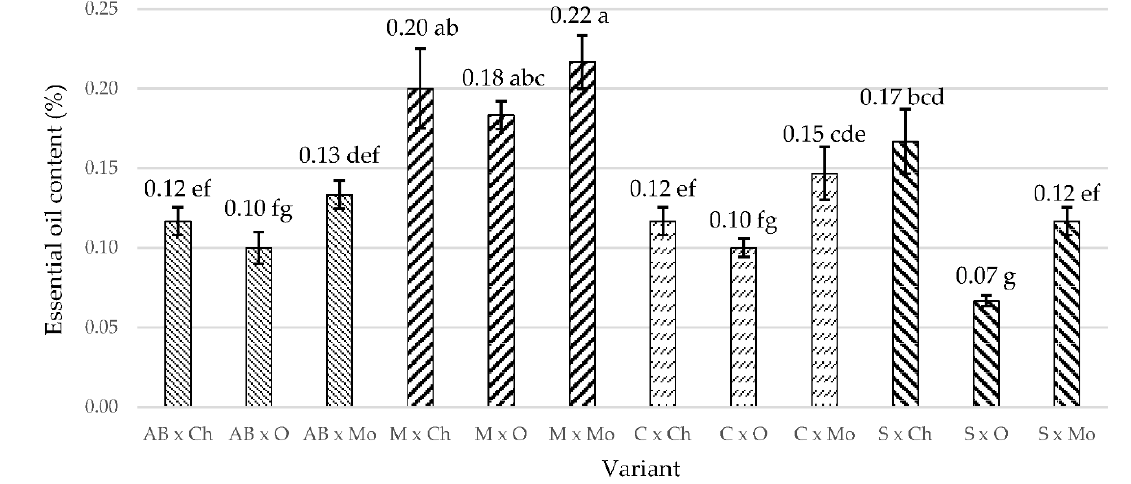
Figure 1. Interaction effects of cultivar and fertilization on essential oil content. Values associated with the same lowercase letters are not statistically different at p < 0.05 according to Duncan’s test. AB—‘Aromat de Buzau’; M—‘Macedon’; C—‘Cuisoare’; S—‘Serafim’; Ch—chemical; O—organic; Mo—microorganisms.